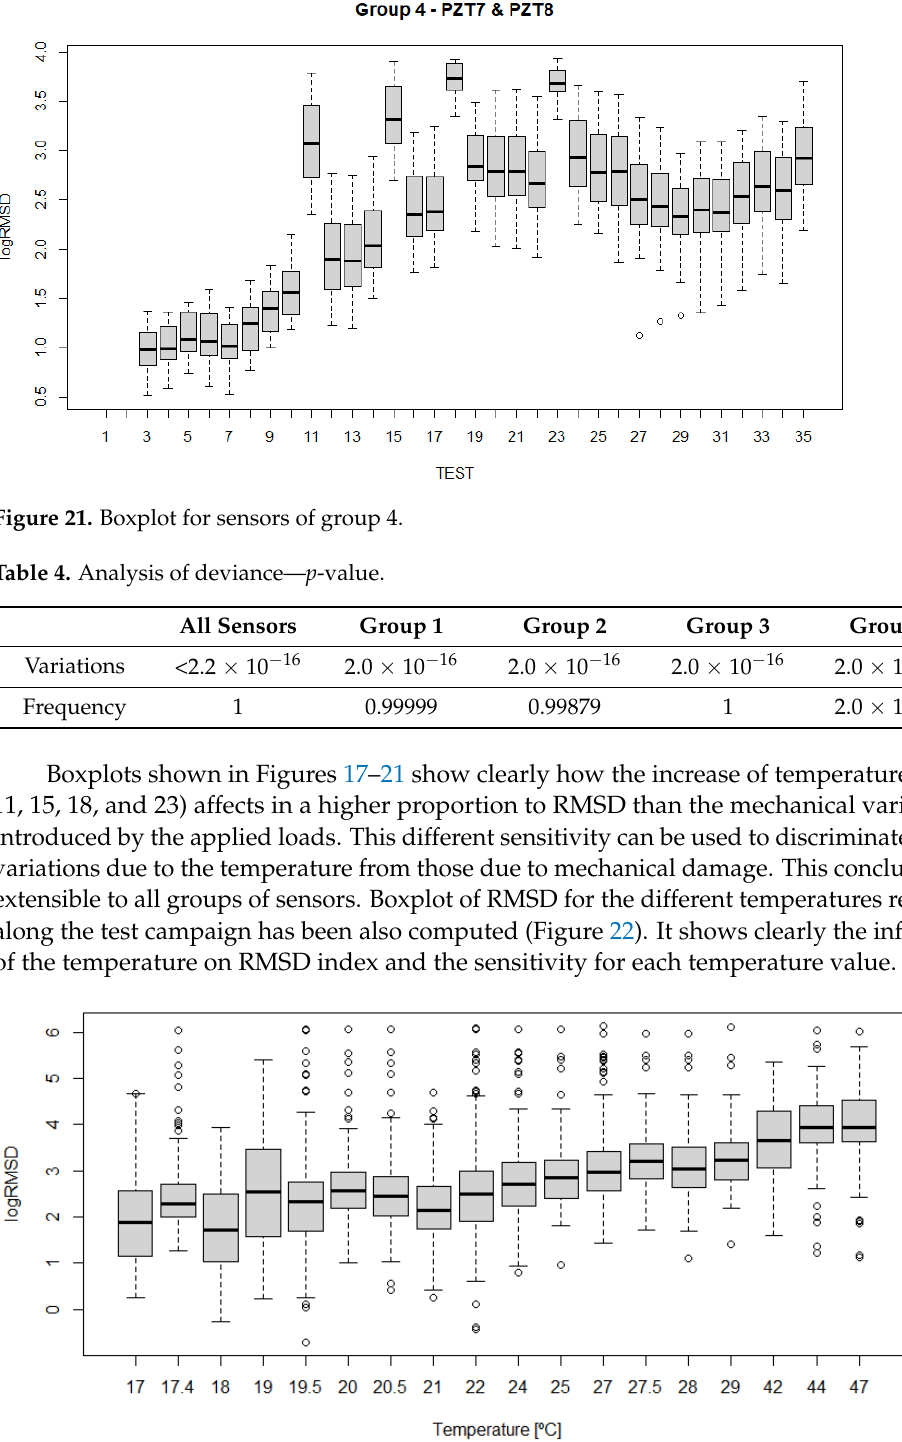
Figure 22. Effect of temperature on log(RMSD). Table 4. Analysis of deviance— p